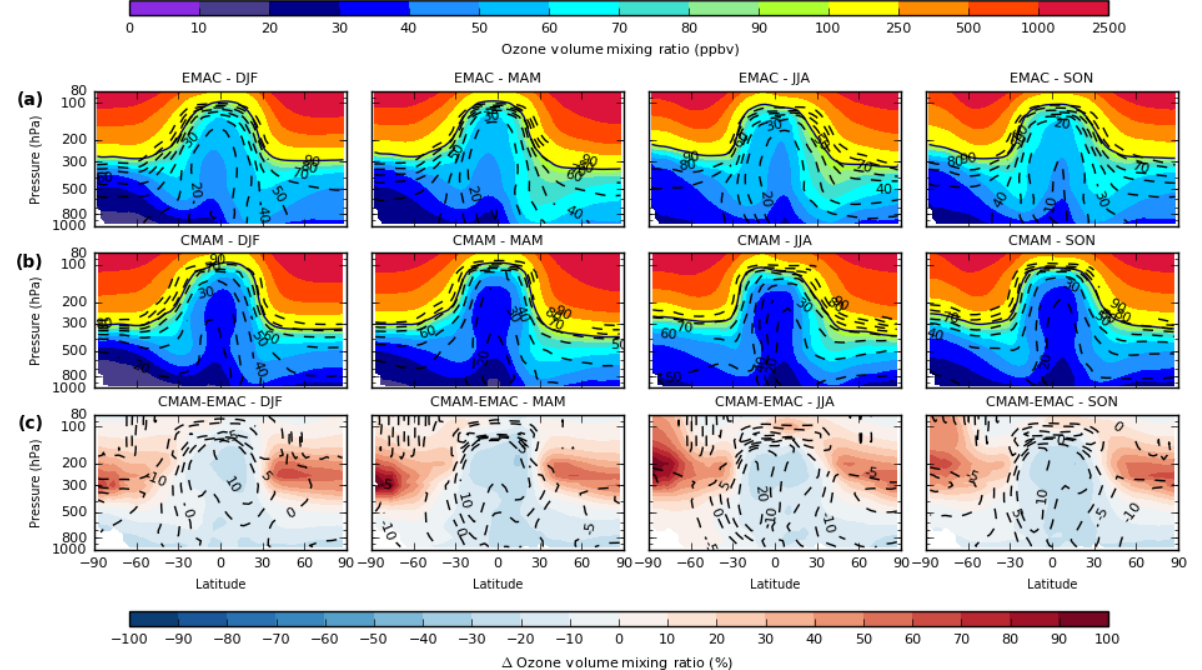
Figure 5. Zonal mean seasonal composites of monthly mean O 3 VMR (ppbv) for the troposphere and lower stratosphere (1000–80hPa) from (a) EMAC, (b) CMAM, and (c) CMAM and EMAC (CMAM-EMAC) percentage differences over the period 1980–2010. Dashed lines indicate the stratospheric contribution (%) calculated using both ozone tracers in each model: O 3 F (%) = (O 3 S / O 3 ) × 100. The 100ppbv contour (bold line) is included as a reference for the tropopause altitude ( a–b